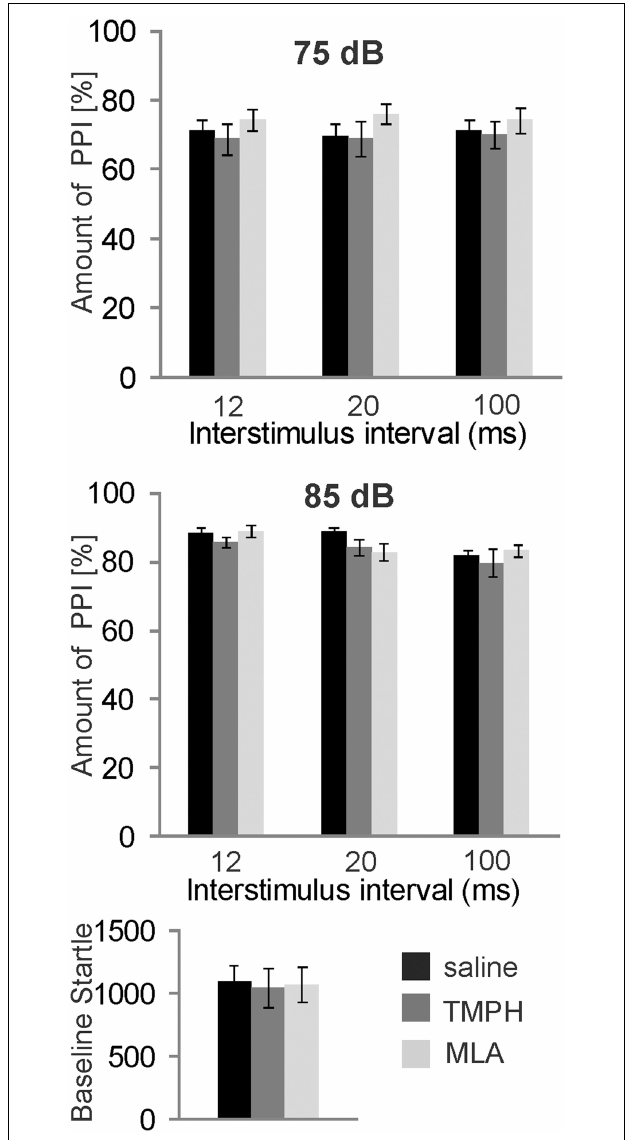
FIGURE 1 | Systemically injected nicotine antagonists do not affect PPI. Prepulse inhibition was measured using a 75 or 85dB white noise prepulse preceding the startle pulse by different intervals, as indicated. The amount of PPI was calculated using the intermingled trials without prepulse as baseline startle (0% PPI). Rats were systemically injected with saline, the α 7nAChR preferring antagonist MLA, or the non- α 7nAChR antagonist TMPH at doses previously shown to be effective. There was no effect of drug on PPI at prepulse levels of 75dB ( top ), or 85dB (middle ). Baseline startle amplitudes were analyzed during the habituation block (see Materials and Methods; n = 8 rats per group).There was also no effect of drug on the baseline startle response amplitude ( bottom